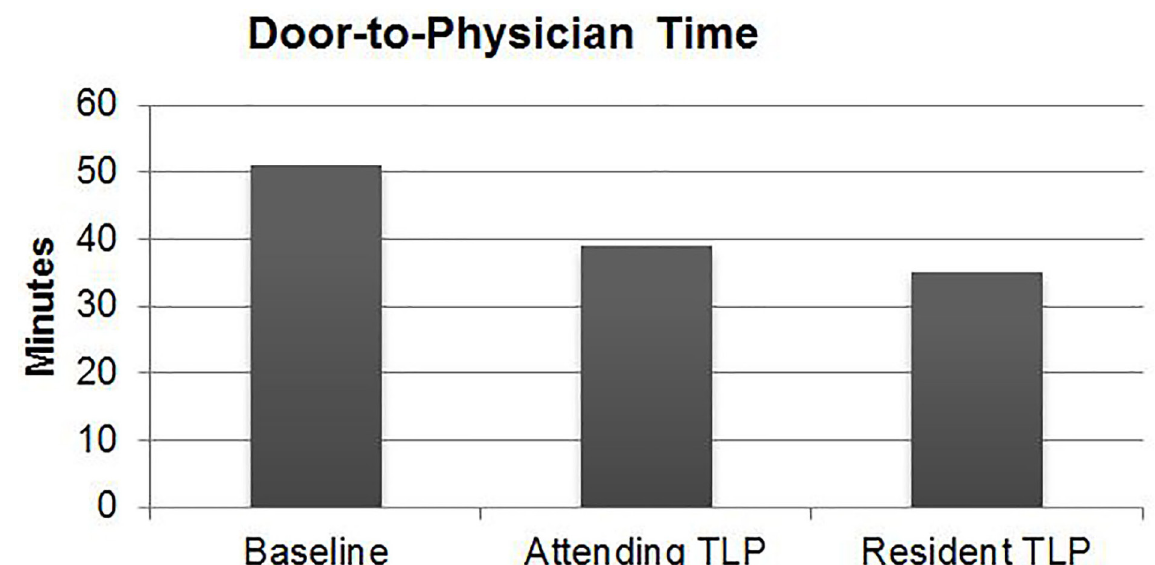
Figure 4. Difference in door-to-physician time between attending triage liaison provider (TLP), resident TLP, and historical